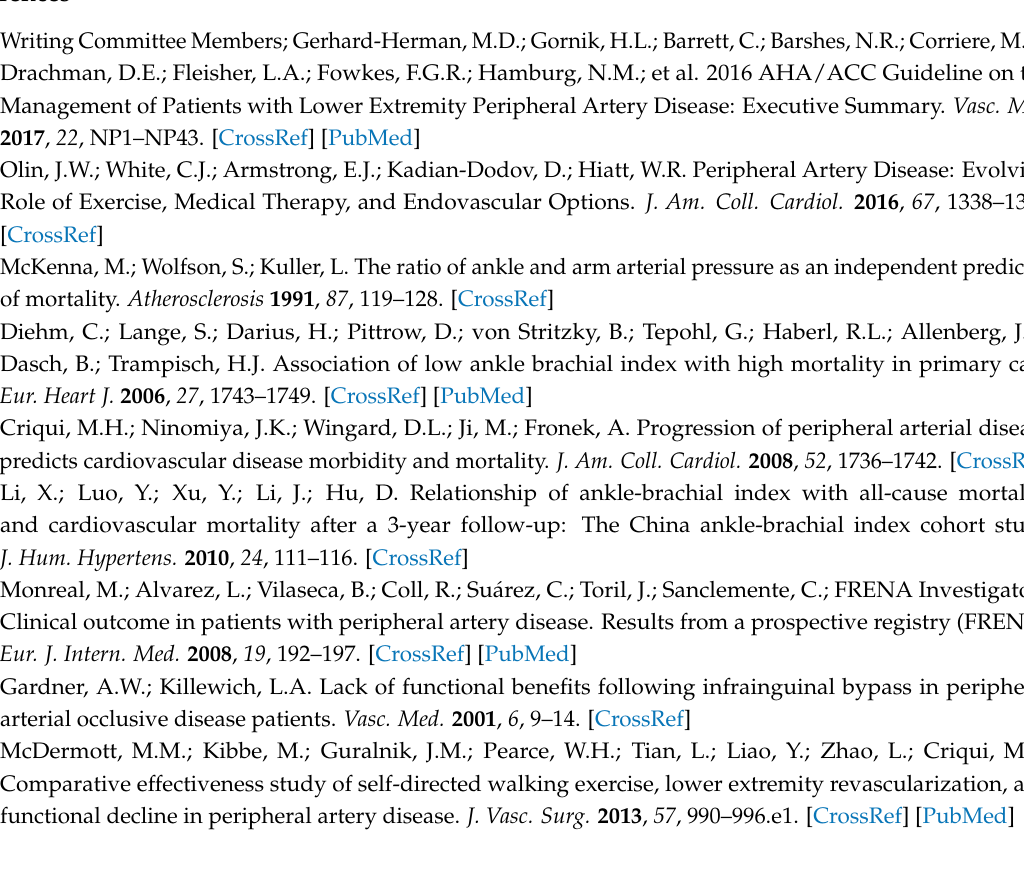
Figure S1: More impaired limb ankle-Brachial indexes and maximal speed distribution in the whole population at baseline (blue) and at discharge (orange), Figure S2: Forest plots showing association between PAD-related revascularizations and study variables in the moderate (A) and severe (B)